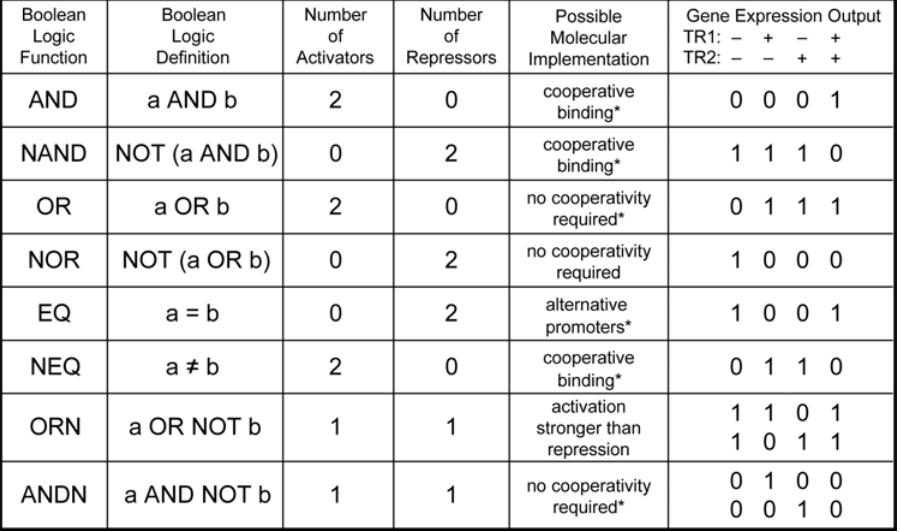
Figure 7. Two-input Boolean logic functions at the single promoter level in bacteria. Boolean logic functions are listed in the first column with their corresponding formal definitions given in the second column. The next two columns indicate the number of distinct activators and repressors required to generate the logic phenotype. The second to last column displays various molecular schemes mostly proposed by Buchler et al. [11] (marked by an asterisk) for implementing specific Boolean logic function at complex promoters. Many of these logic functions require intricate molecular schemes involving either regulator cooperativity or the presence of alternative promoters [11]. Hermsen et al [16] have recently proposed molecular implementations based on cooperative/competitive binding of several TRs for all of these logics. The last column displays Boolean output as a function of the binding states of two transcriptional regulator, TR1 and TR2, inputs at the promoter: ‘ + ’ (bound) and ‘ 2 ’ (not bound). Collectively, these functions represent a complete set of all two-input Boolean functions having outputs that depend on the state of both inputs.